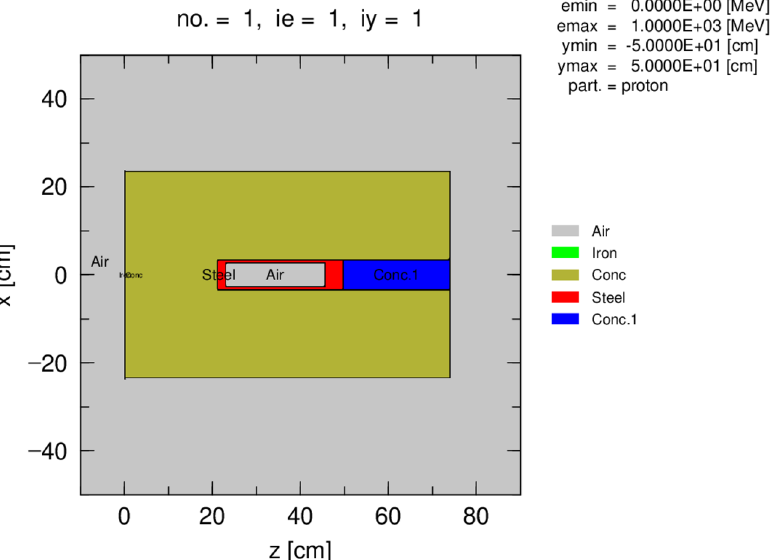
Figure 3. Output Geometry of the simulation designed for DSRSs waste management optimization generated by PHITS. Different components of the geometry with the materials used and their dimensions.